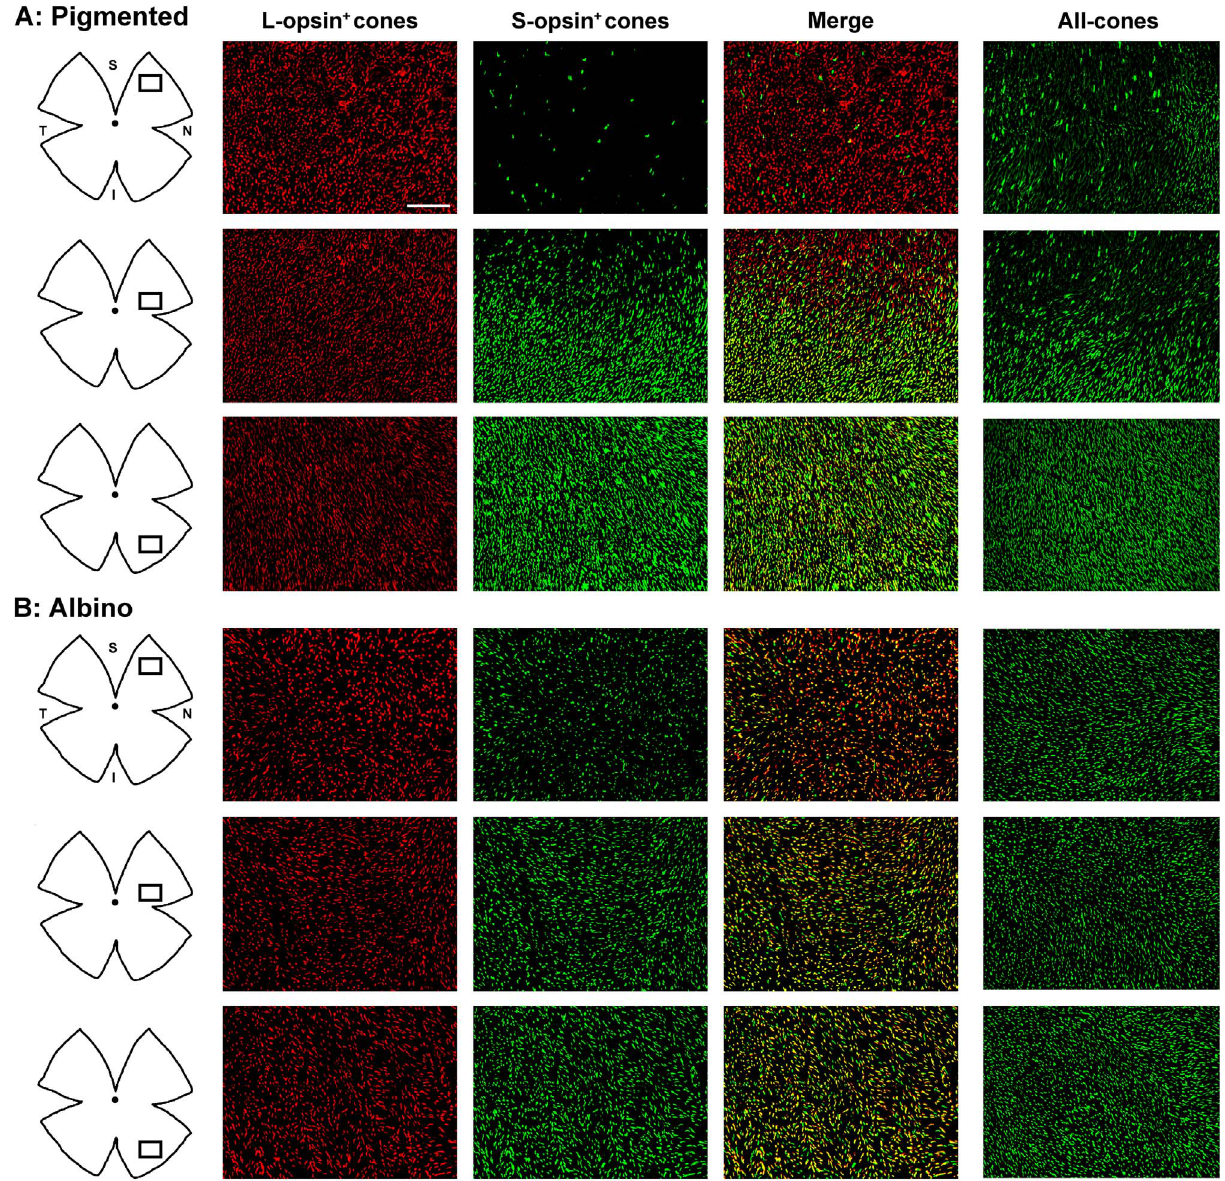
Figure 2. Opsin expression in pigmented and albino mice. Magnifications from pigmented ( A ) and albino ( B ) mice flat mounted retinas showing L-opsin + cones, S-opsin + cones and their merged image. The rightmost column shows all-cones (both opsins developed with the same fluorophore). In the retinal drawings on the left, is shown the area where the magnifications were taken from. S-opsin + cones are sparse in the superior retina of the pigmented strain and abundant in the albino one. In both strains most genuine S-cones are found in the inferior retina. In the pigmented strain majority of genuine L-cones lay in the superior retina, while in the albino mouse majority of L-cones are dual. And so dual cones are found across the retina in the albino strain and mostly restricted to the ventral retina in the pigmented one. S: superior, N: nasal, I: inferior, T: temporal. Bar: 100 m m. 40% dual cones, while in the albino strain about 73% of cones are dual, 23% are genuine S, and 4% are genuine L ( Figure 3 ). Therefore, to quantify the whole cone population in the pigmented strain both opsins should be detected whereas in the albino strain immunodetection of the S-opsin suffices, because 96% of its cones express it.